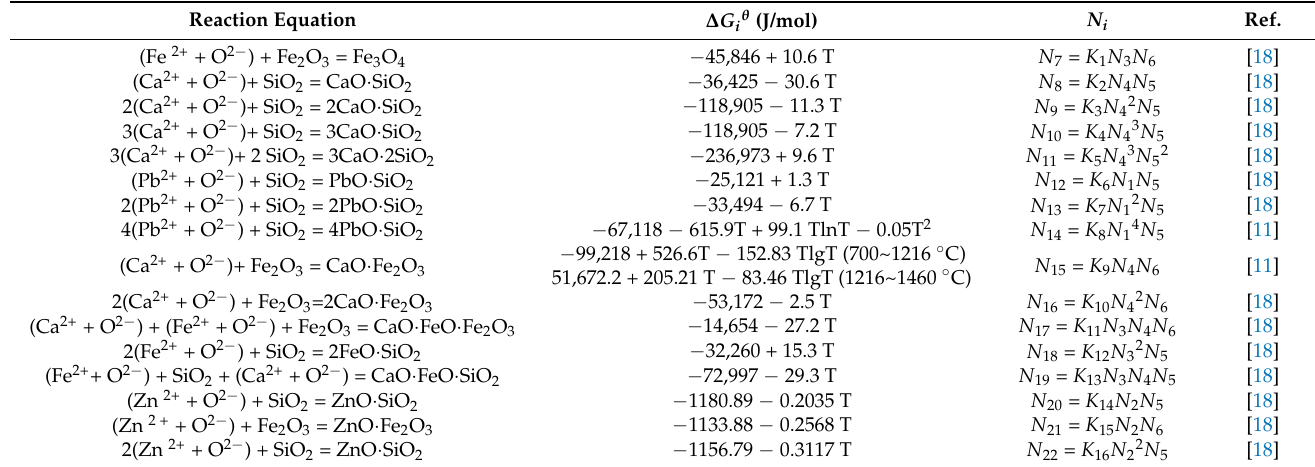
Table 3. Complex molecule generation reaction equations and their ∆ G i θ and N i